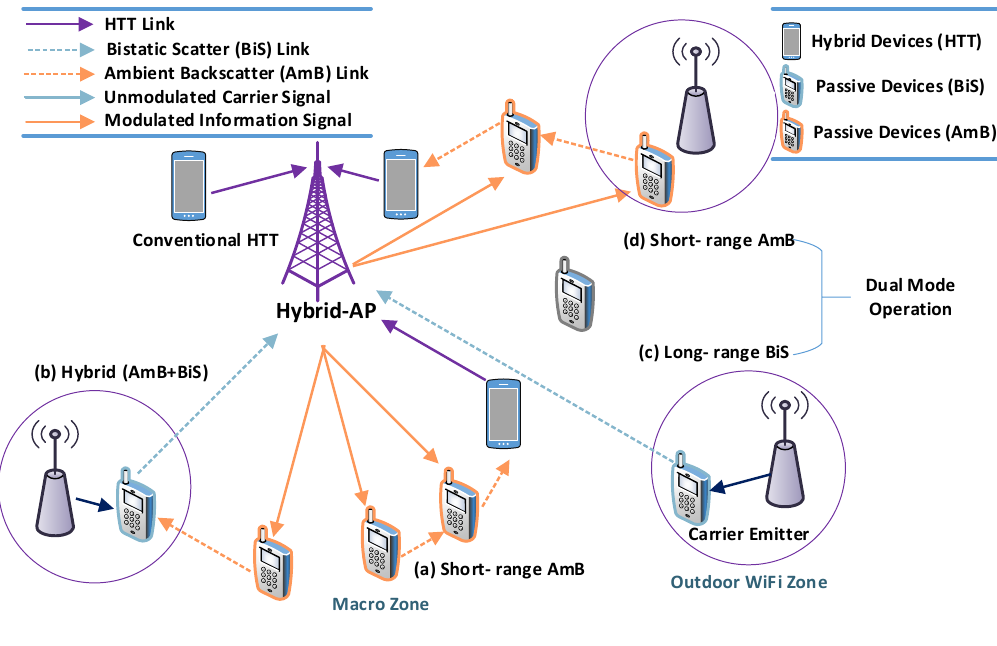
Figure 11. Hybrid